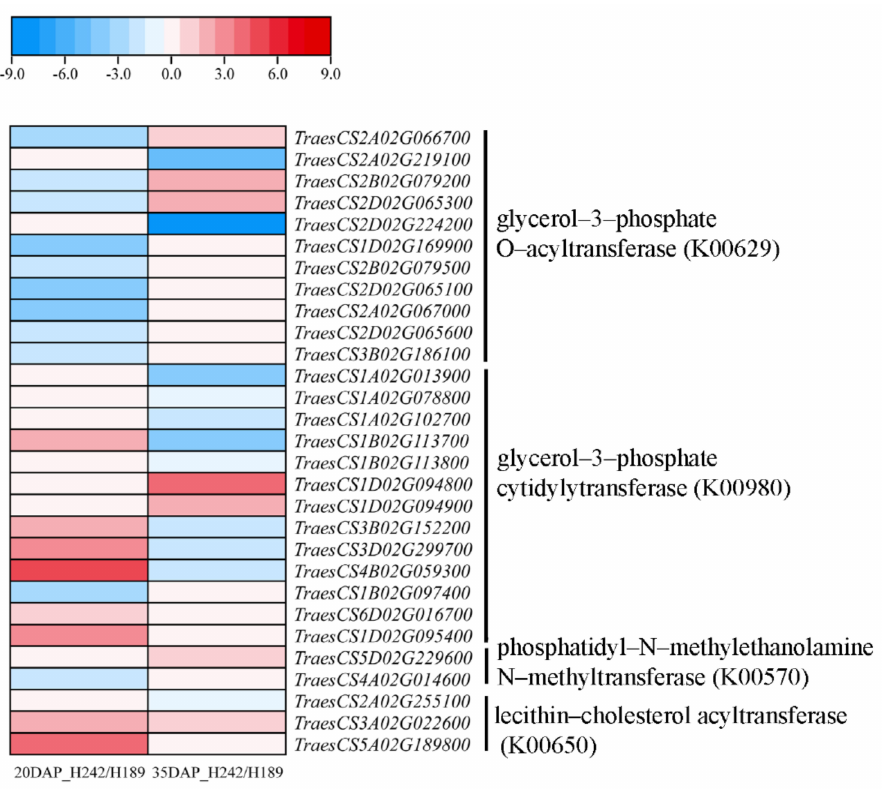
Figure 4. Heatmap of DEGs involved in lipid